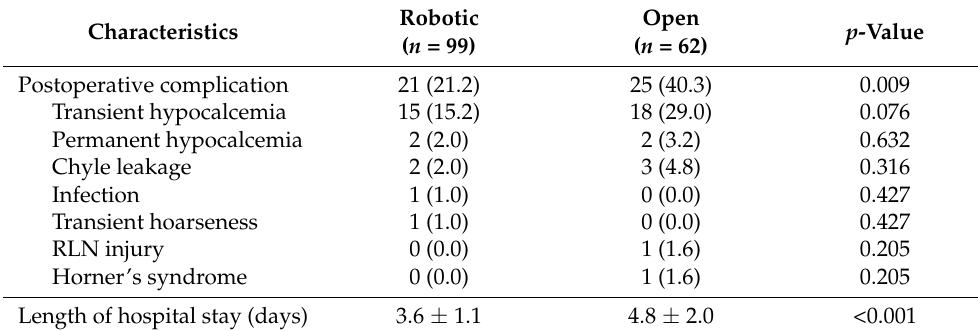
Table 5. Comparison of postoperative outcomes between patients treated with robotic and open